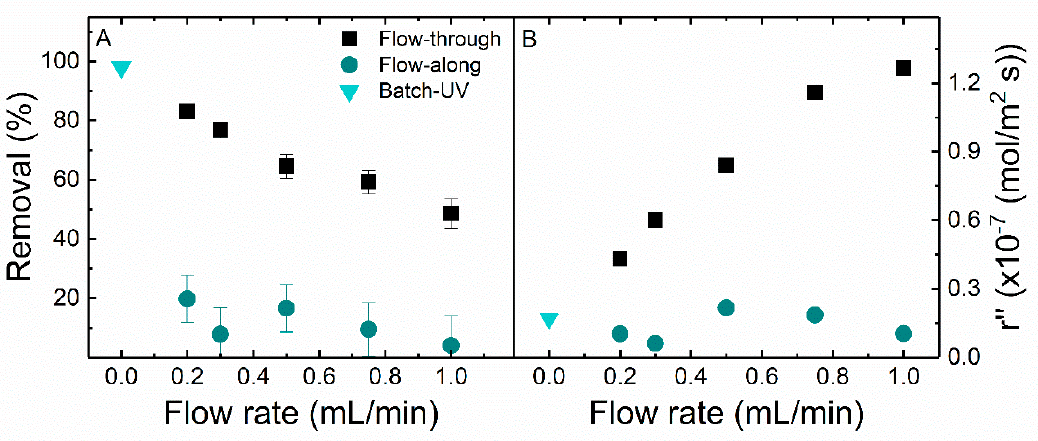
Figure 7. ( A ) MB removal, and ( B ) photocatalytic membrane reaction rate for batch (11.3 ± 1.3 mW/cm 2, 0 flow rate), flow-along and flow-through reactors at different flow rates: 10 mW/cm 2 light intensity, 1 mg/L concentration, 22 °C, in flow-along and flow-through pH 8.6, 1 mM NaHCO 3 , 10 mM NaCl.